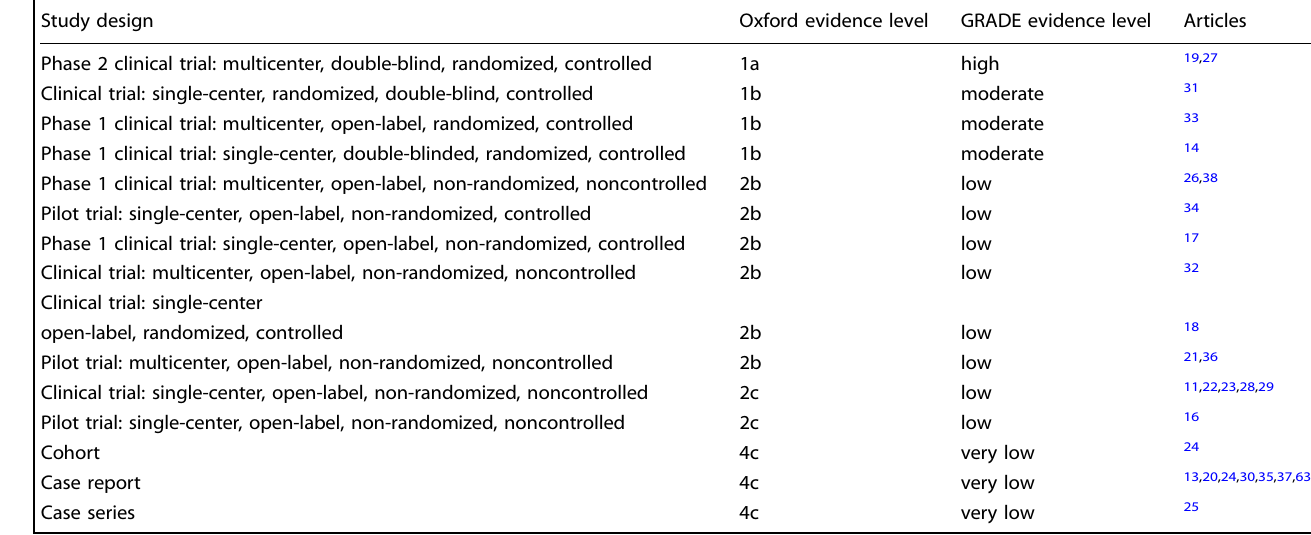
Table 2. Study designs and evidence levels.